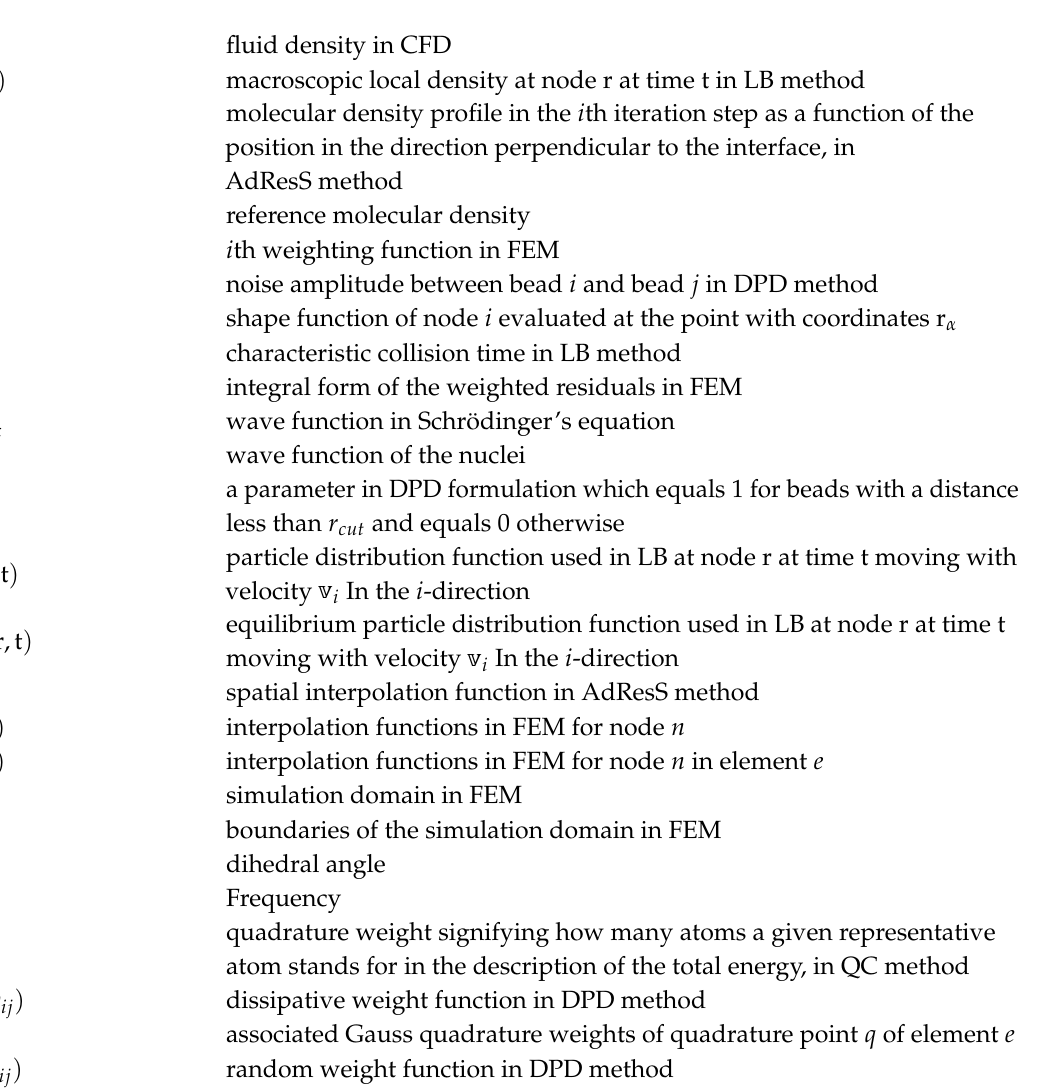
Figure 1. Two typical lattices often used in LB simulations: ( a ) D2Q9; and ( b ) D3Q19.